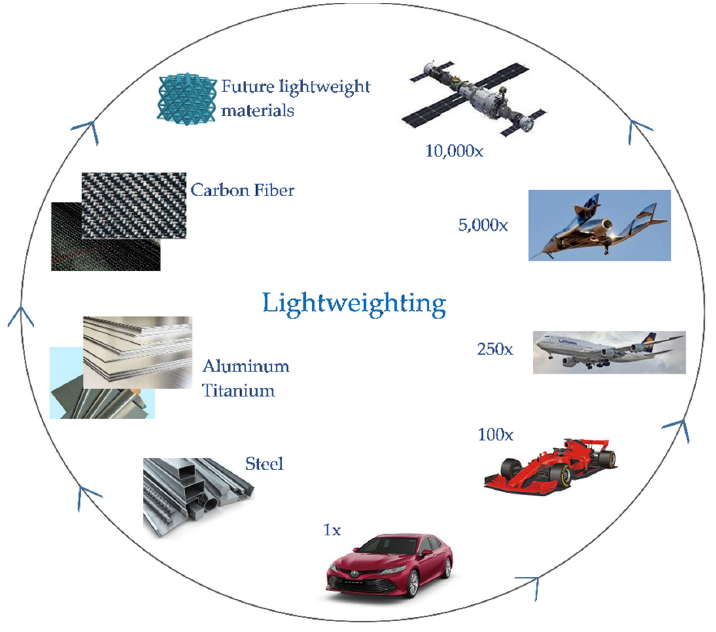
Figure 20. Schematics of the relative lightweighting cost in different sectors of transportation and the associated progress in lightweight materials.